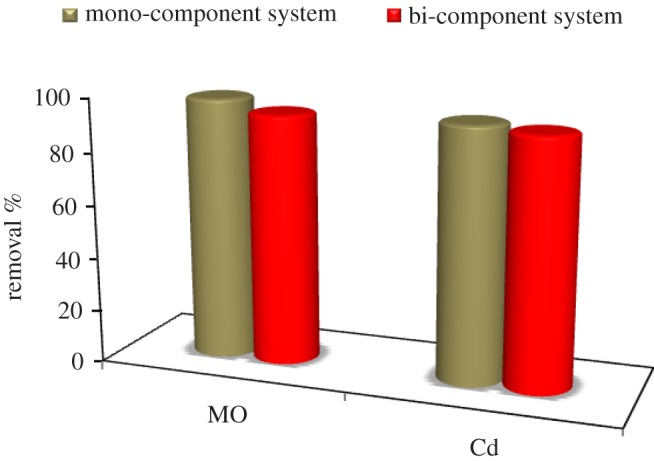
MO and Cd2+ removal efficiency from mono- and bi-component pollutant solution by TiO2/ASS (1 : 2) nanocomposite.